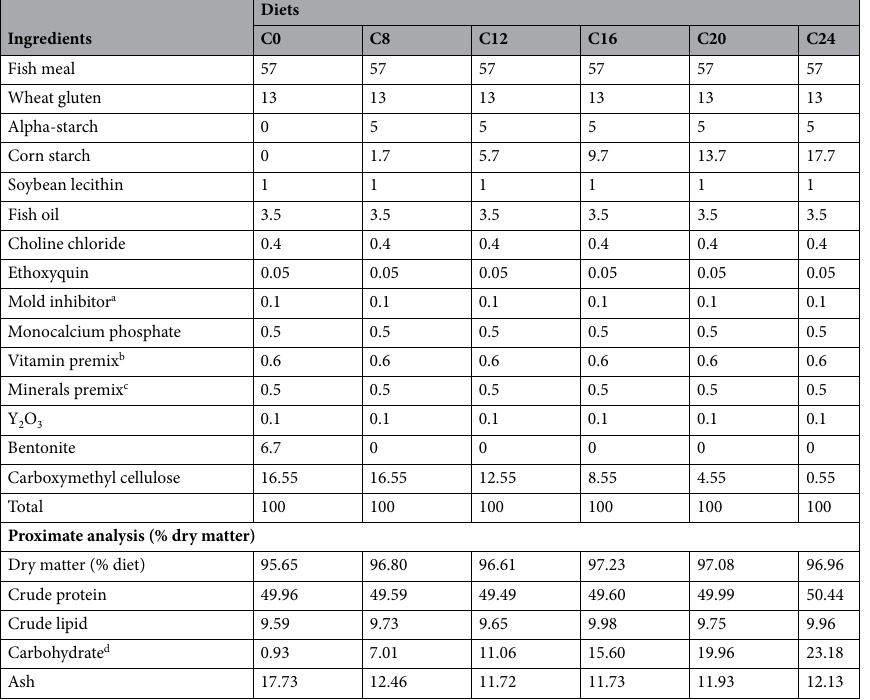
Table 4. Formulation and proximate compositions of the experimental diets (% of dry matter). a Mold